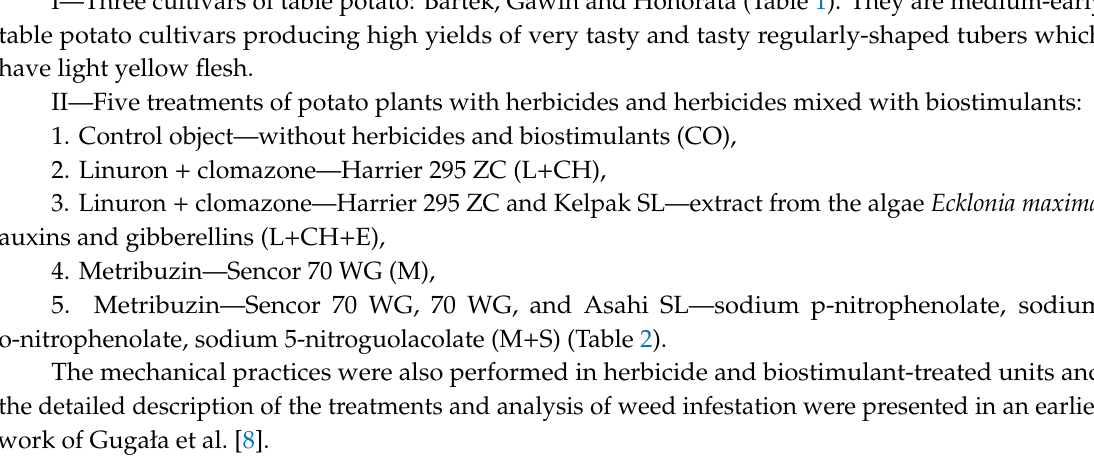
have light yellow flesh.